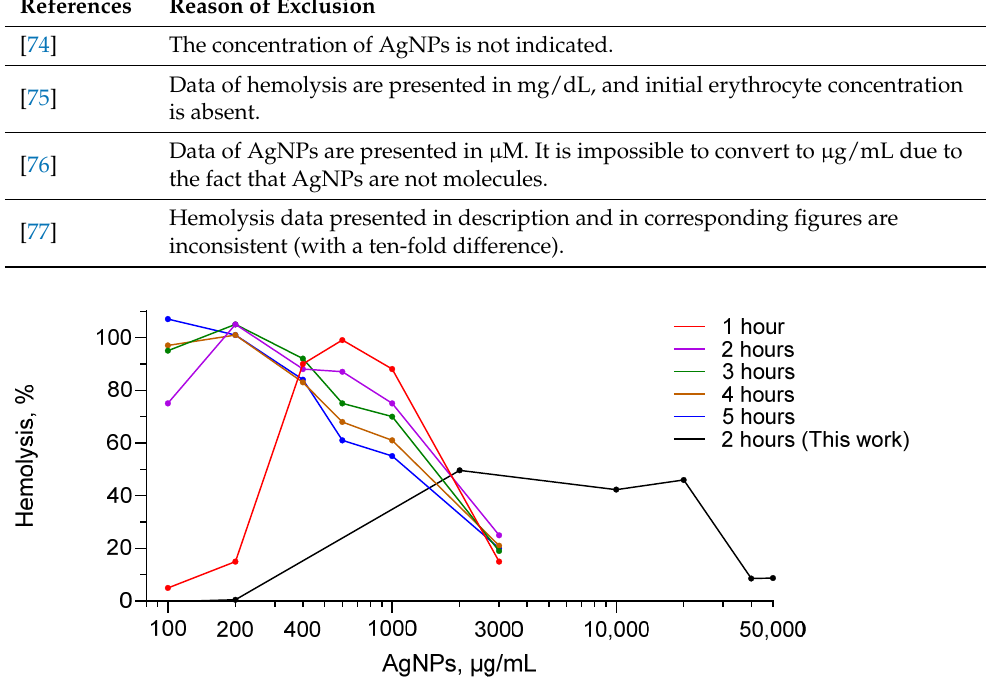
Figure 6. Human erythrocytes hemolysis induced by AgNPs at pH 7.4: data Adapted from Ref. [37] (colored curves) and data of the present work (black curve).